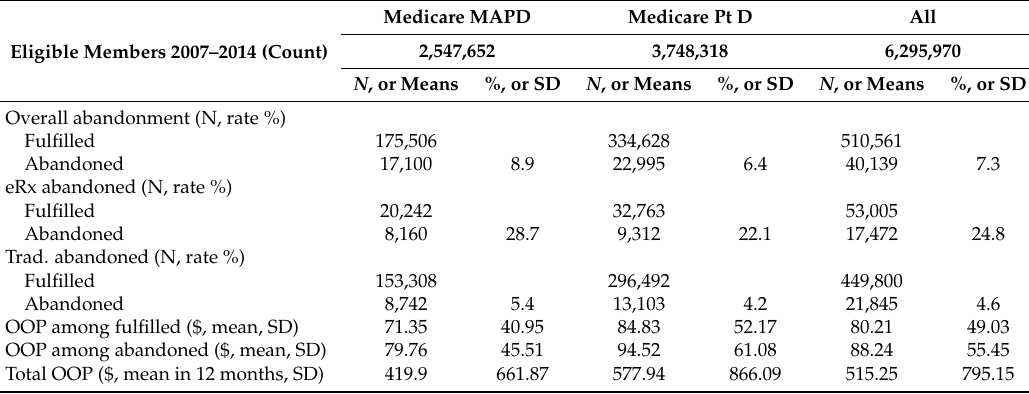
Table 2. Utilization of HZ Vaccine in Eligible Adults by Coverage Type. OOP: out of pocket.